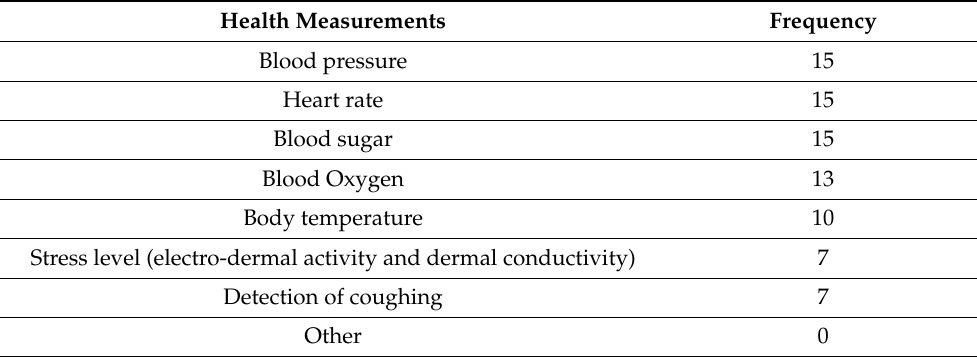
Table 10. Results of selected health measurements for monitoring (select multiple options allowed).